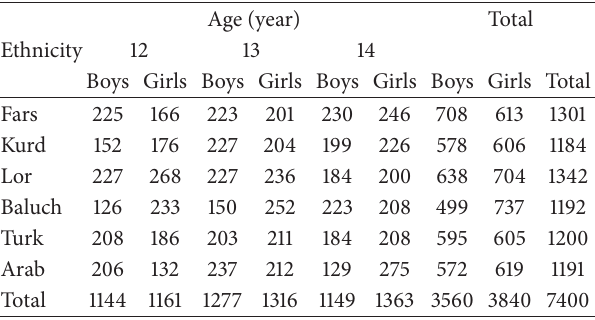
Table 2: Sample size of the subjects in different ethnicities and age